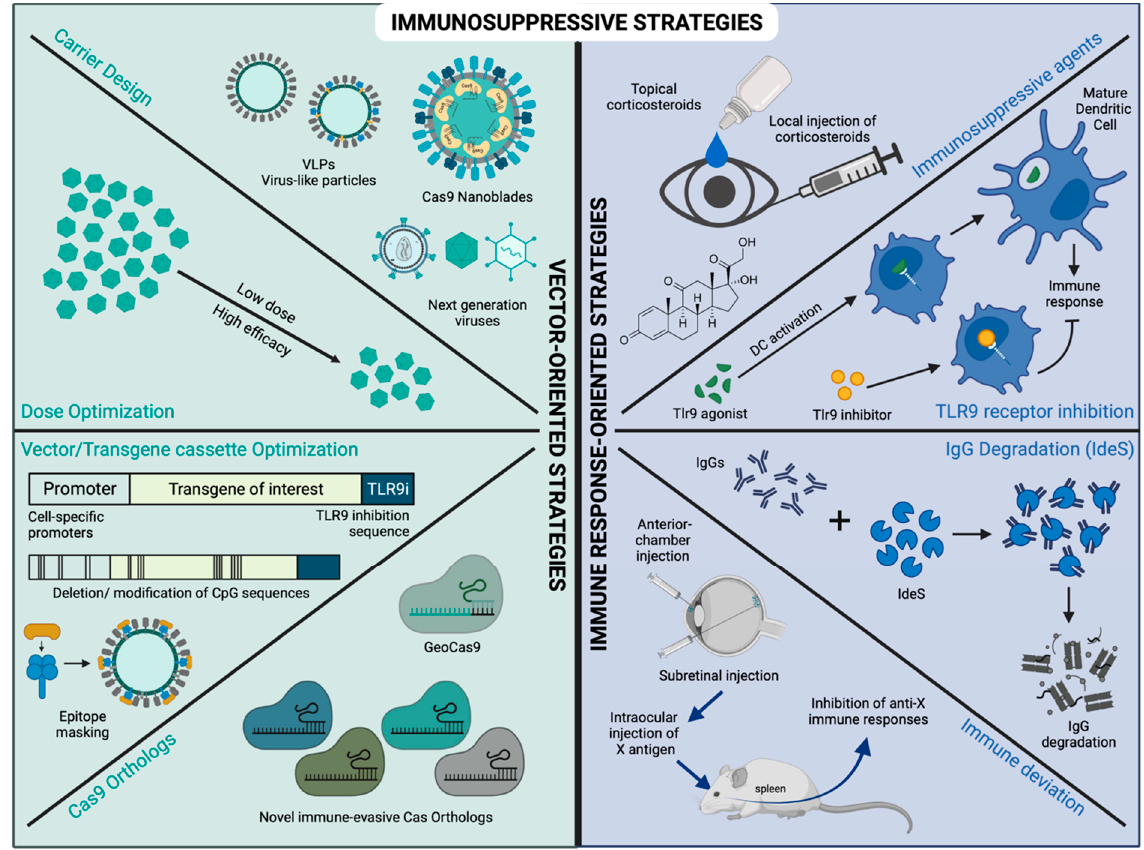
Figure 2. Schematic representation of immunosuppressive strategies . Strategies to suppress or control immune responses to gene therapy can be broadly categorized as vector-oriented or immune-response-oriented strategies. Vector-oriented strategies focus on design and dose of the carrier and the elements packaged within. Novel carriers are being designed with immune-evading properties such as the next generation of viruses as well as non-viral carriers such as virus-like particles (VLPs) and nanoblades. A higher dose poses a higher risk of exposure to danger signals; hence, the dose needs to be optimized to achieve the highest therapeutic efficacy with the lowest dose possible. Cell-specific promoters are more specific and less immunogenic than ubiquitous promoters. An addition of a TLR9 inhibition sequence (Tlr9i), dele- tion of CpG-rich regions in the transgene cassette and masking of TLR9 binding epitopes on the capsid have been shown to reduce TLR9-mediated immune responses. Novel Cas9 orthologs, to which a prior exposure has not occurred, may be less immunogenic. Immune-response-oriented strategies focus on avoiding or reducing the immune responses. An im- munosuppressive regimen consisting of corticosteroids can be provided as topical eye drops or ocular injections before and after the gene therapy. TLR9 inhibitors can be used to prevent the activation of dendritic cells, thereby preventing cellular immune responses. Enzymatic cleavage of pre-existing anti-vector antibodies can be achieved by using enzymes such as IdeS. Immune deviation can be achieved by prior exposure to antigens by injection into the anterior chamber or subretinal